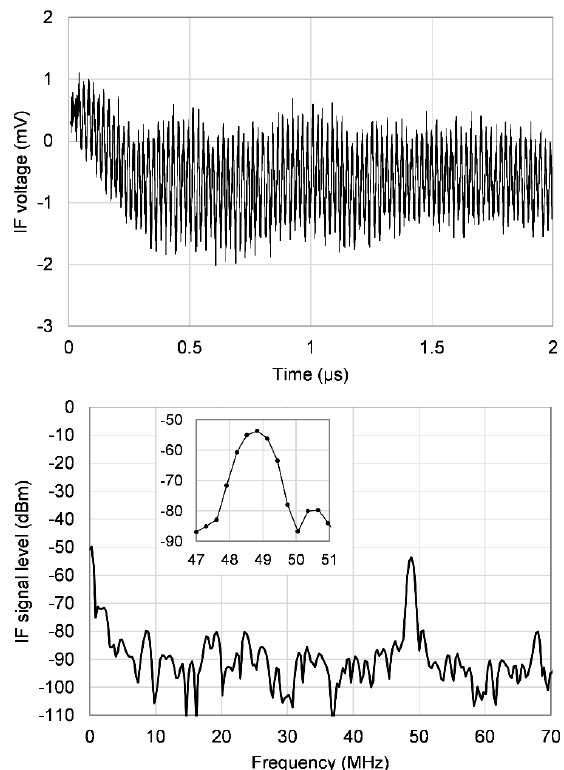
Figure 3. An example of the IF beat signal. Top: the IF signal recorded by the oscilloscope. The period is 2 µs and the modulation frequency is swept from 3.4 to 6.4 GHz. Bottom: the Fourier transform of the IF signal, showing a peak near 49 MHz; the inset expands the region around the peak. This figure is for illustration only and does not correspond to any of the other results in the paper; the signal shown here was recorded after a series of improvements increased the signal-to-noise ratio.